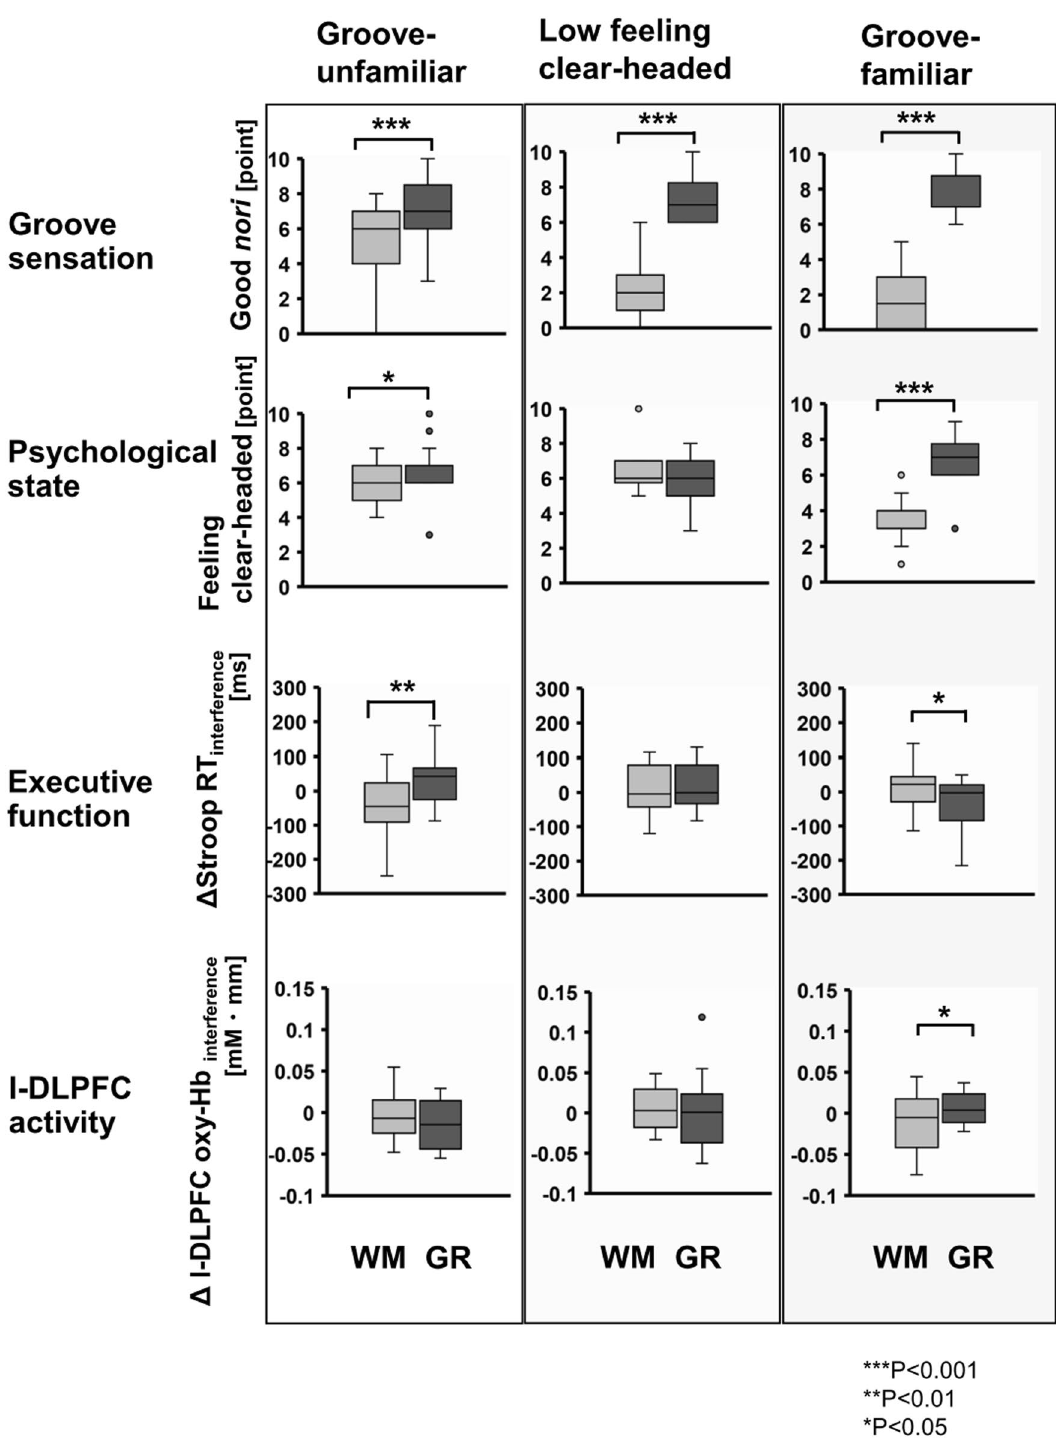
Figure 3. The comparison between conditions of “Good nori ” score, “Feeling clear-headed” score, ΔStroop RT interference , and Δl-DLPFC oxy-Hb interference within each cluster. In cluster 1 ( “Groove familiar”), ΔStroop RT interference in the GR condition was shorter than in the WM condition. Conversely, in cluster 3 (“Groove unfamiliar”), ΔStroop RT interference in the GR condition was longer than in the WM condition. Values are represented as box plots where the bottom, middle, and top lines of the boxes are the 25th, 50th (median), and 75th percentiles, respectively, and the whiskers above and below each box indicate the most extreme point within 1.5 times the interquartile range. The points above or below the whiskers represent outliers. *** P < 0.001, ** P < 0.01, * P <